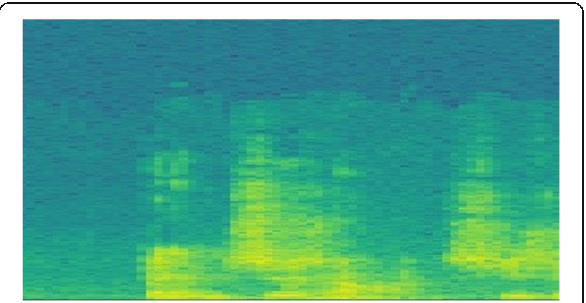
Fig. 6 Spectrogram of an audio